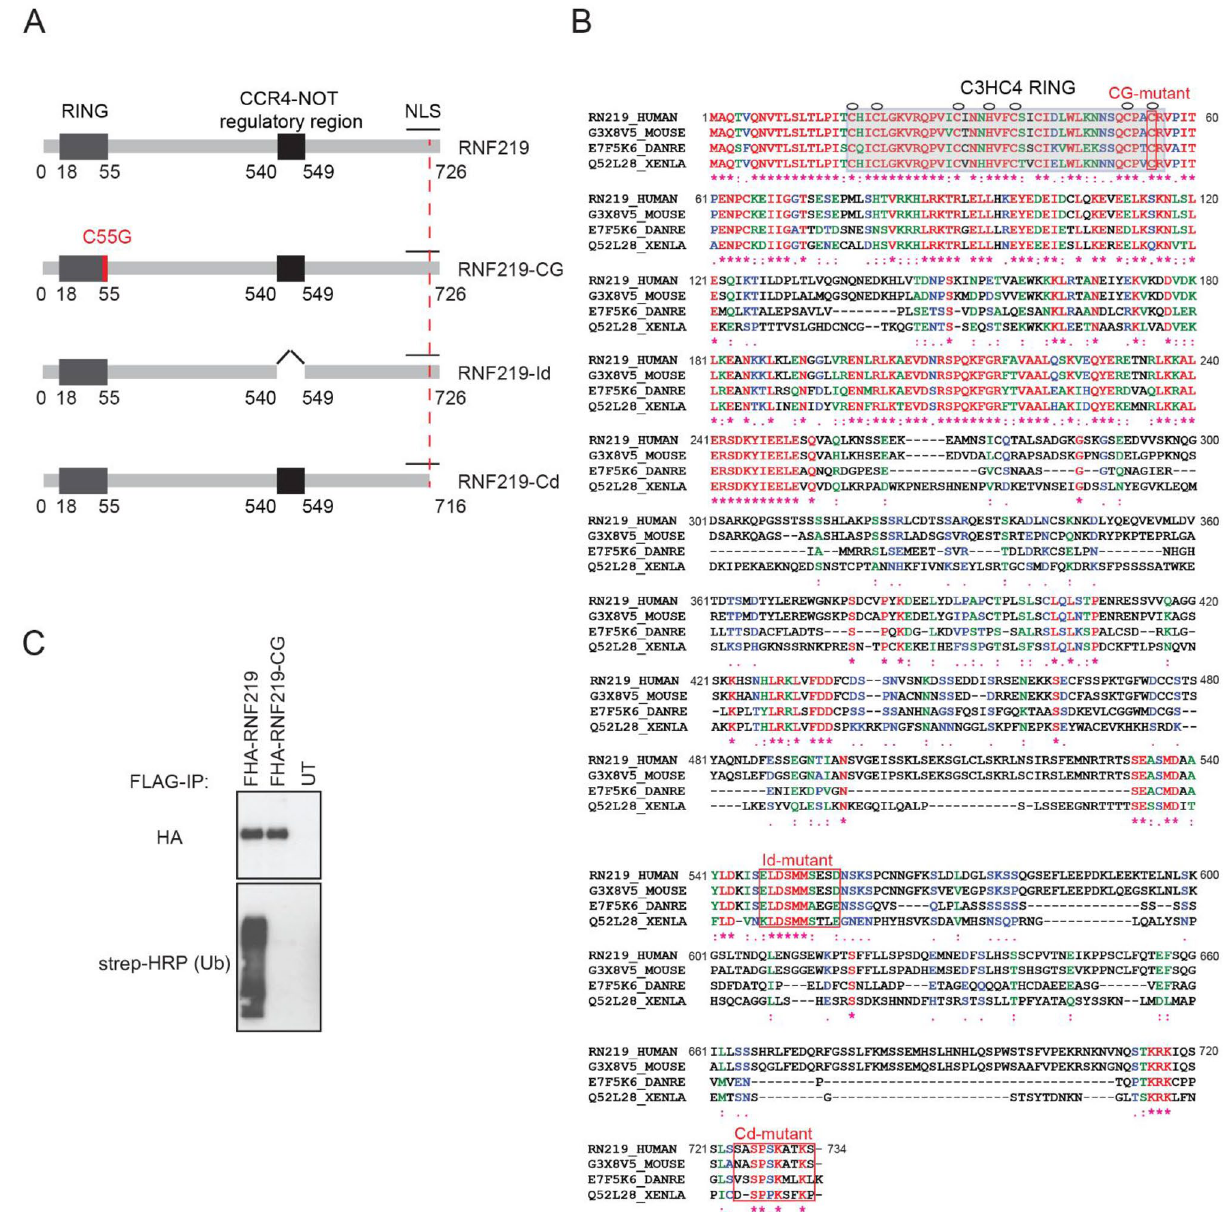
Figure 1. RNF219 is a RING dependent ubiquitin ligase. ( A ) Schematic representation of the RNF219 protein and mutants used in this study. ( B ) Sequence alignment of the human hRNF219 protein and its Mus musculus , Xenopus laevis and Danio rerio , orthologs. Amino acid sequences were aligned with the Prabi CLUSTALW tool. Identical residues are annotated with an asterisk (*) and coloured in red, whereas similar residues are annotated with two (:) and coloured in green and less similar residues are annotated with one dot (.) and coloured in blue. One conserved RING domain of C3HC4 type was predicted in the N-terminus of all the conserved alignments (highlighted in grey); Zinc coordinating residues are marked with a circle. Mutated residues and corresponding mutants are highlighted by a red box. ( C ) RNF219 but not the RING domain mutant can form poly-ubiquitin chains in an in vitro assay. FHA-RNF219 and FHA-RNF219-CG (cysteine 55 was replaced by a glycine) affinity purified under high salt condition with FLAG antibody and peptide eluted from transfected 293T cells, were incubated with E1 enzyme, UBCH5a, and biotinylated ubiquitin (lanes 1 and 2, respectively). The third lane contains the purification from untransfected cells as negative control. Ubiquitin was detected with HRP conjugated streptavidin